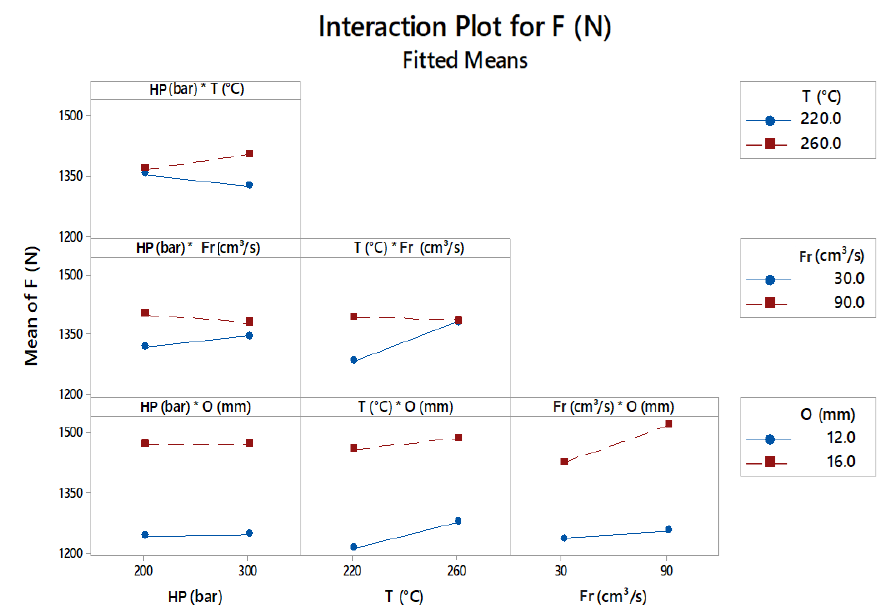
Figure 8. Interactions between factors and the adjusted means.